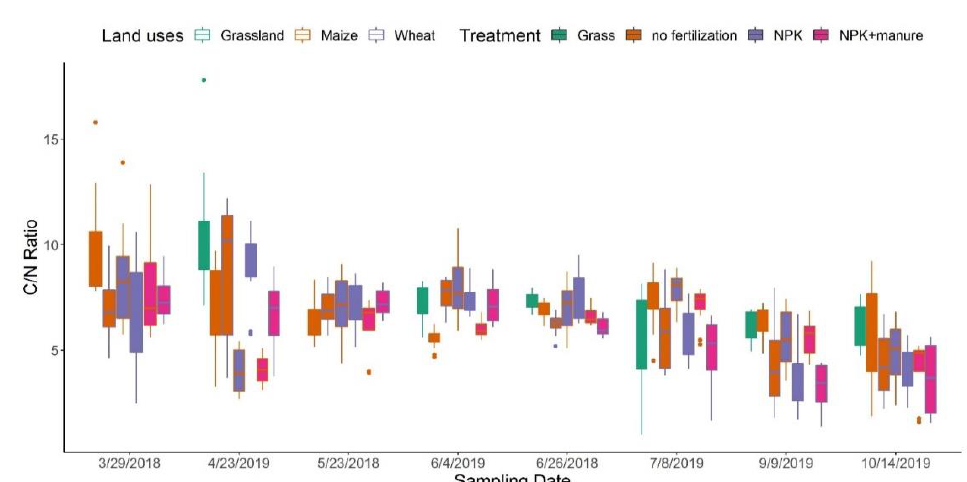
Figure 3. Stoichiometric carbon to nitrogen (C/N) ratio in cropland and grassland plots under different treatments and across crop cover. Sample size was n = 12, total sample size was n = 648; dots indicate outliers. NPK: nitrogen, phosphorus, potassium fertilization.